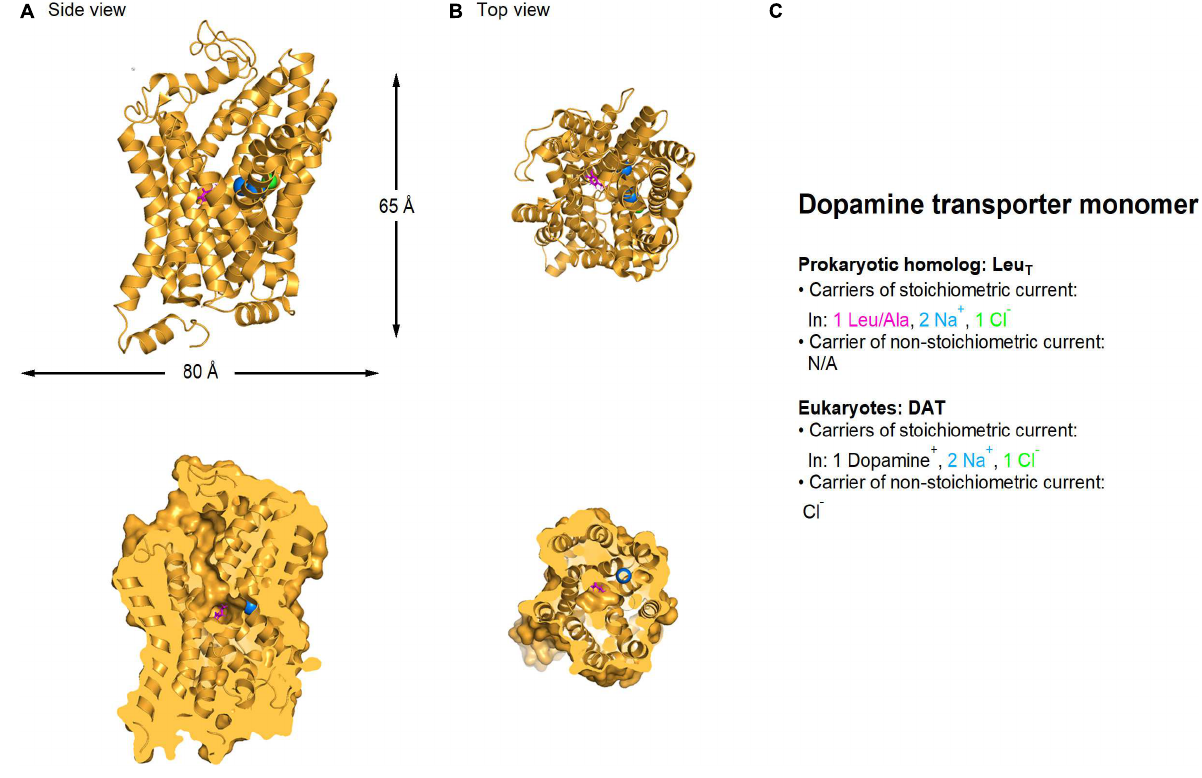
FIGURE 3 | Crystal structure of Drosophila melanogaster dDAT dopamine transporter (PDB: 4XP1). (A) Side view of the Drosophila dopamine transporter parallel to the membrane, using a ribbon ( top ) and a surface representation sliced through the center of the transporter ( bottom ). (B) As in A, viewed from the extracellular side of the membrane. L -Dopa ( magenta ), sodium ( blue ) and chloride ions ( green ) are represented as spheres. (C) Summary of the main feature of the stoichiometric and non-stoichiometric current mediated by LeuT (prokaryotic dopamine transporter homolog) and DAT transporters in eukaryotes, respectively. Image generated